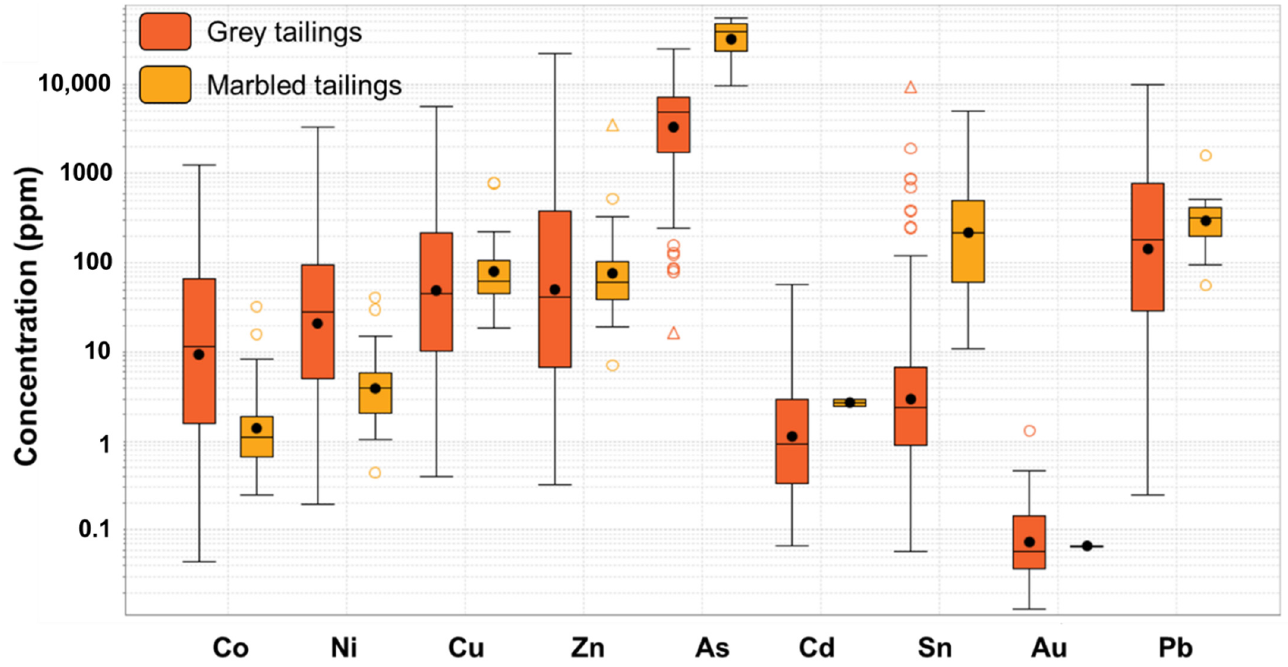
Figure 4. Box and whisker plot summarizing the concentrations (ppm (mg/kg), y -axis) of select elements in pyrite contained in Grey Tailings (dark orange) and Marbled Tailings (orange) sampled in 2015 (NB. Log-scale; data is shown on a Tukey box and whisker plot: the box covers the interquartile range, the line is the median, and the circle the mean. The whiskers are drawn at the threshold to identify near and far outliers based on the Tukey statistic).